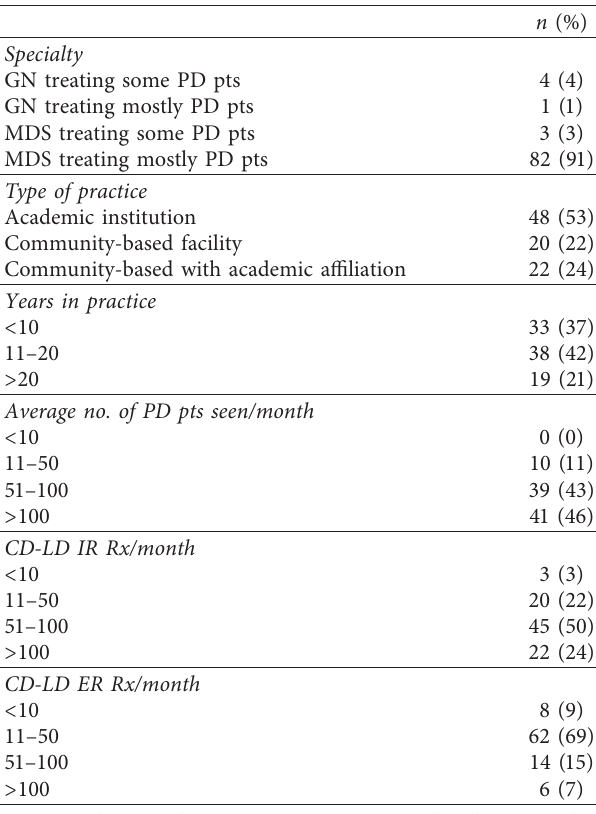
Table 1: Respondent practice